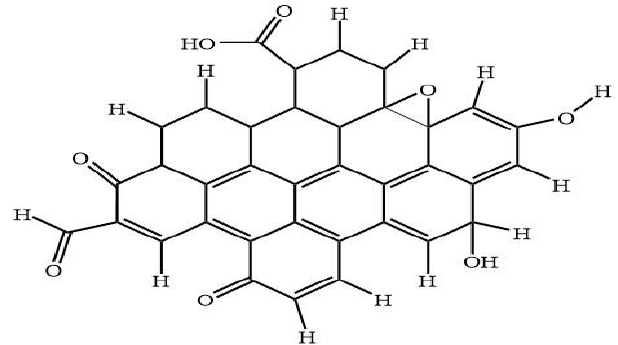
Figure 8. Proposed 2D structure of CQD.